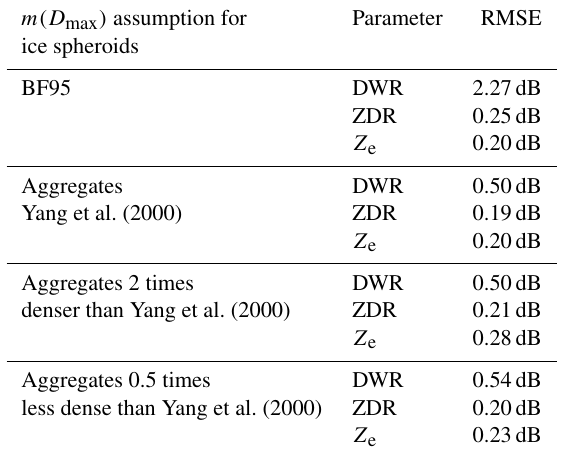
Table 4. RMSE values for simulated ZDR, DWR, and Z e compared to original observations for the whole radar cross-section after run- ning the retrieval for 30 January 2019 at 10:08UTC for oblate ice spheroids and different m(D max )